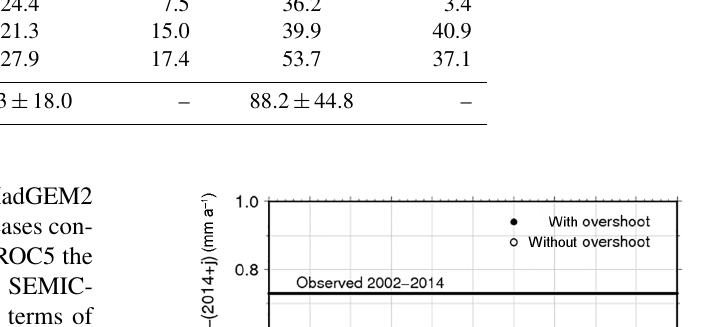
Table 4. Contribution of the Greenland ice sheet to global sea-level change by 2100 and 2300 in millimetres SLE under the RCP2.6 scenario with and without overshoot. Model/ 2100 2300 study with without with without overshoot overshoot overshoot overshoot